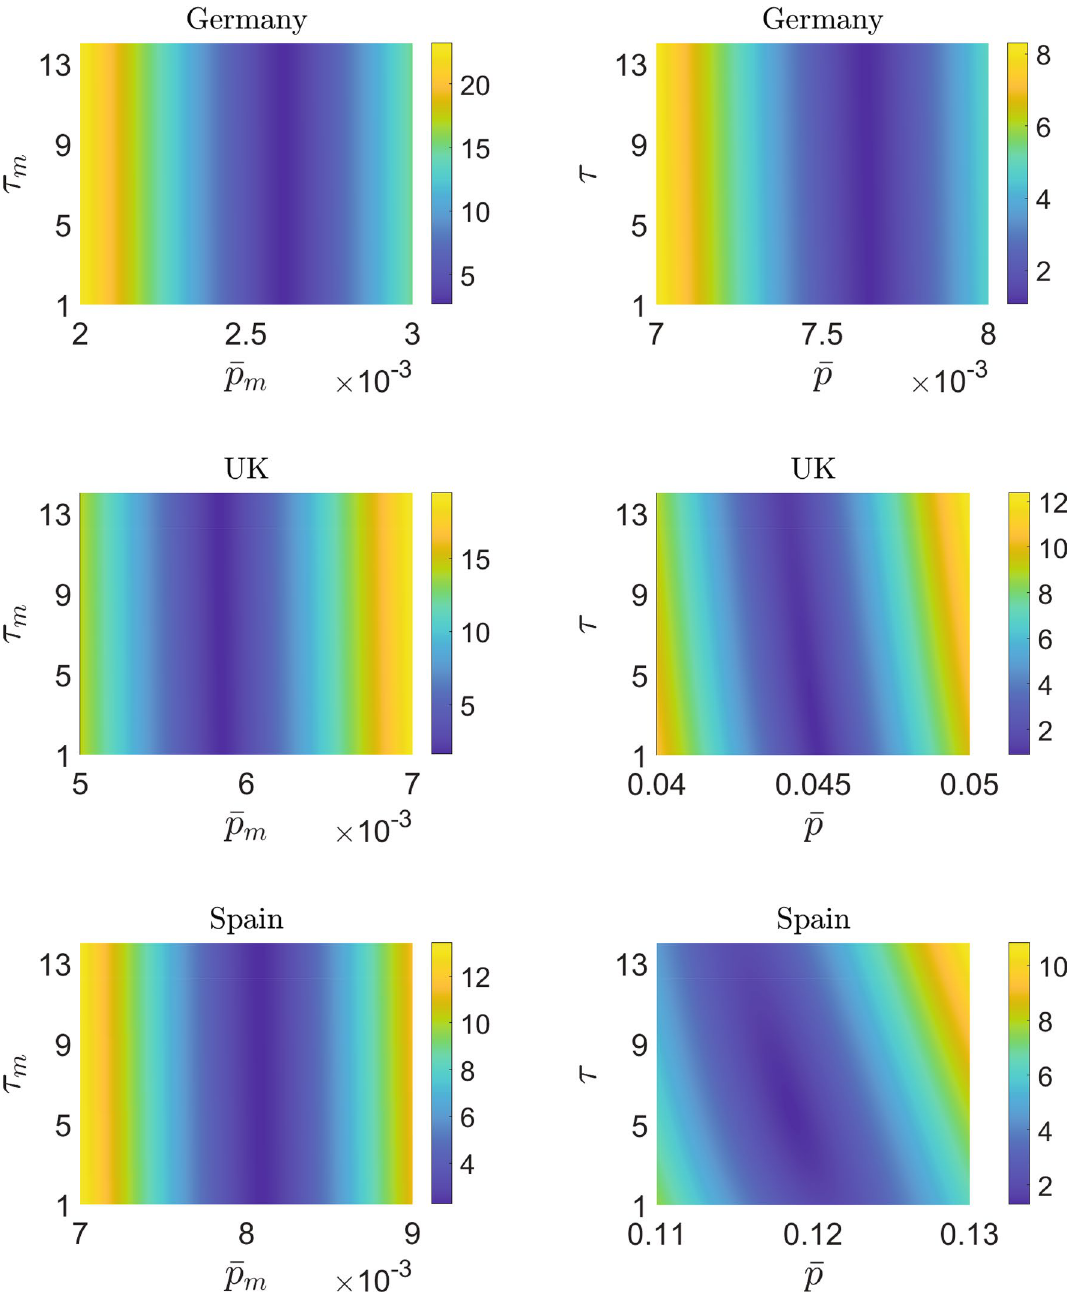
τ m plane (for low values of p m ¯ − p ) obtained from the continuum model. The parameters ¯